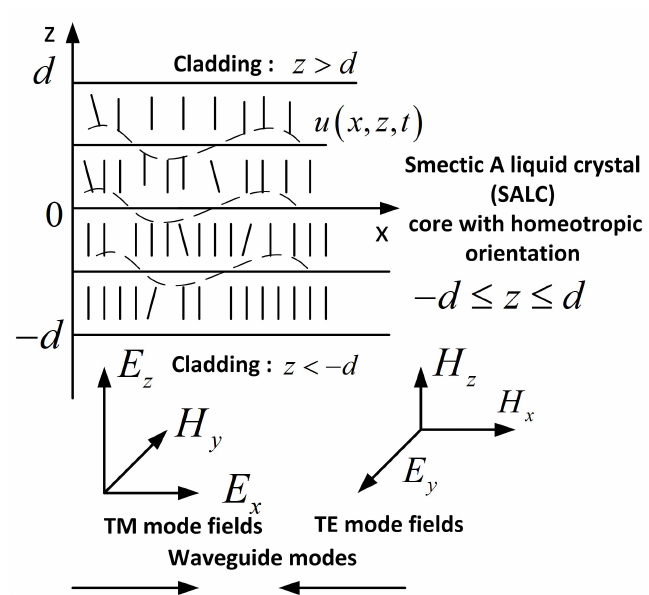
Figure 1. Optical slab waveguide with the homeotropically oriented SALC core of the thickness 2 d . E x , z , H y and E y , H x , z are the electric and magnetic fields of the TM and TE modes, respectively. Optical waves interact through the nonlinear polarization in a medium [37]. Generally, different types of SLS are described by the coupled wave equations for the light waves and for the